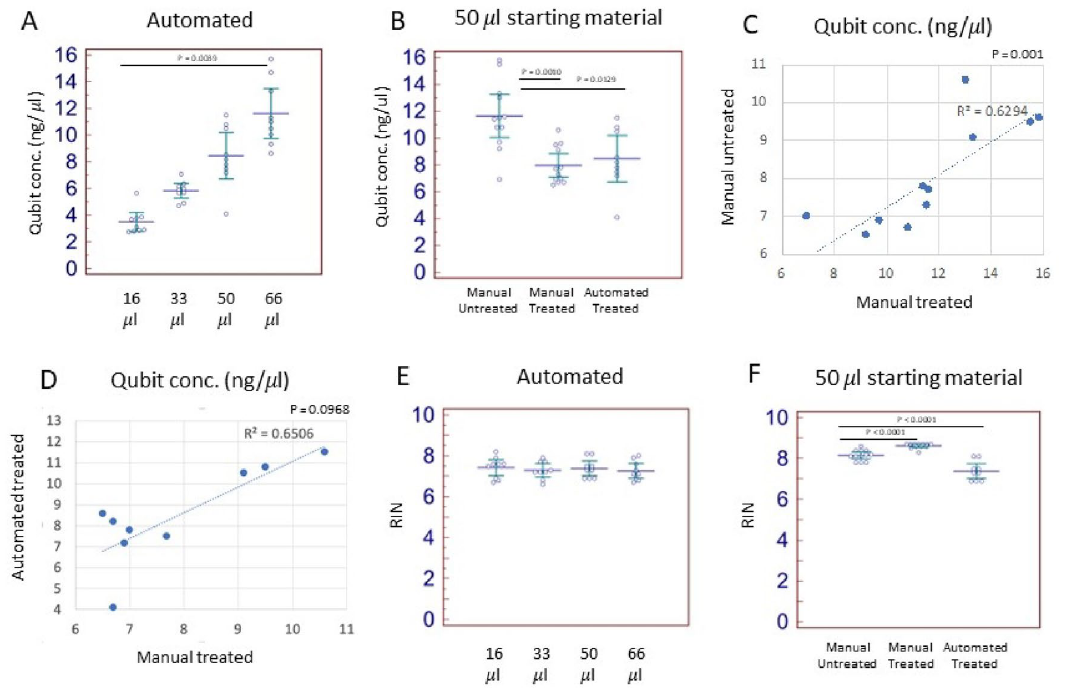
Figure 3. RNA concentration (Qubit, ng/μl) of the automated workflow according to sample volume ( A ). RNA concentration (Qubit, ng/μl) of the 50 μl blood samples according to the extraction method ( B ). Correlation plot of the concentration values of the samples isolated manually as DNA Free-treated and untreated ( C ). Correlation plot of the concentration values of the samples DNA Free-treated isolated manually and on